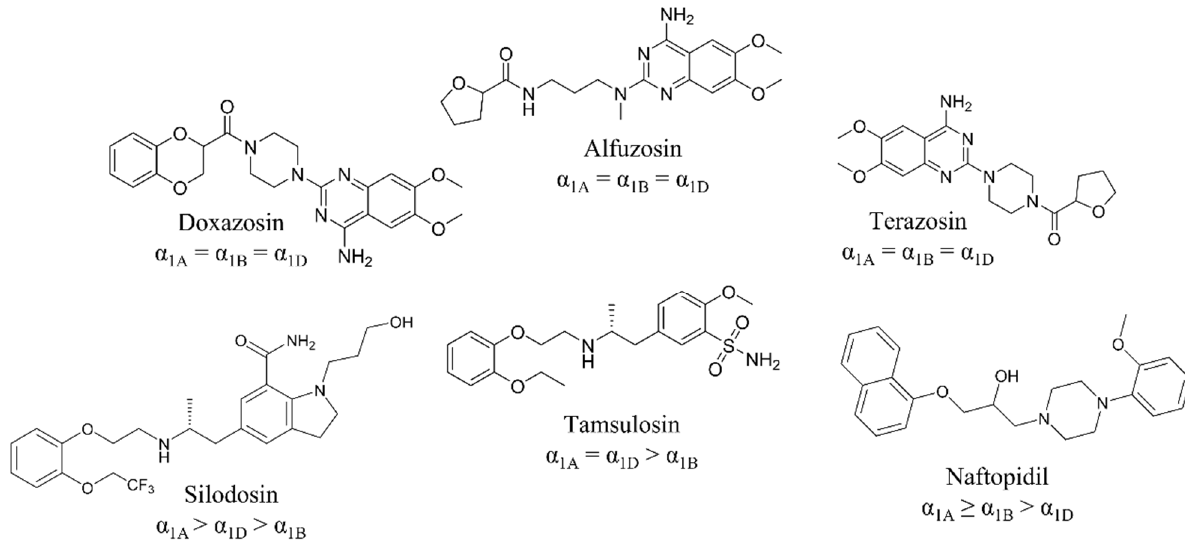
Figure 1. The α 1-AR antagonists in clinical use and their sub-type α -AR (non)selectivity [3].